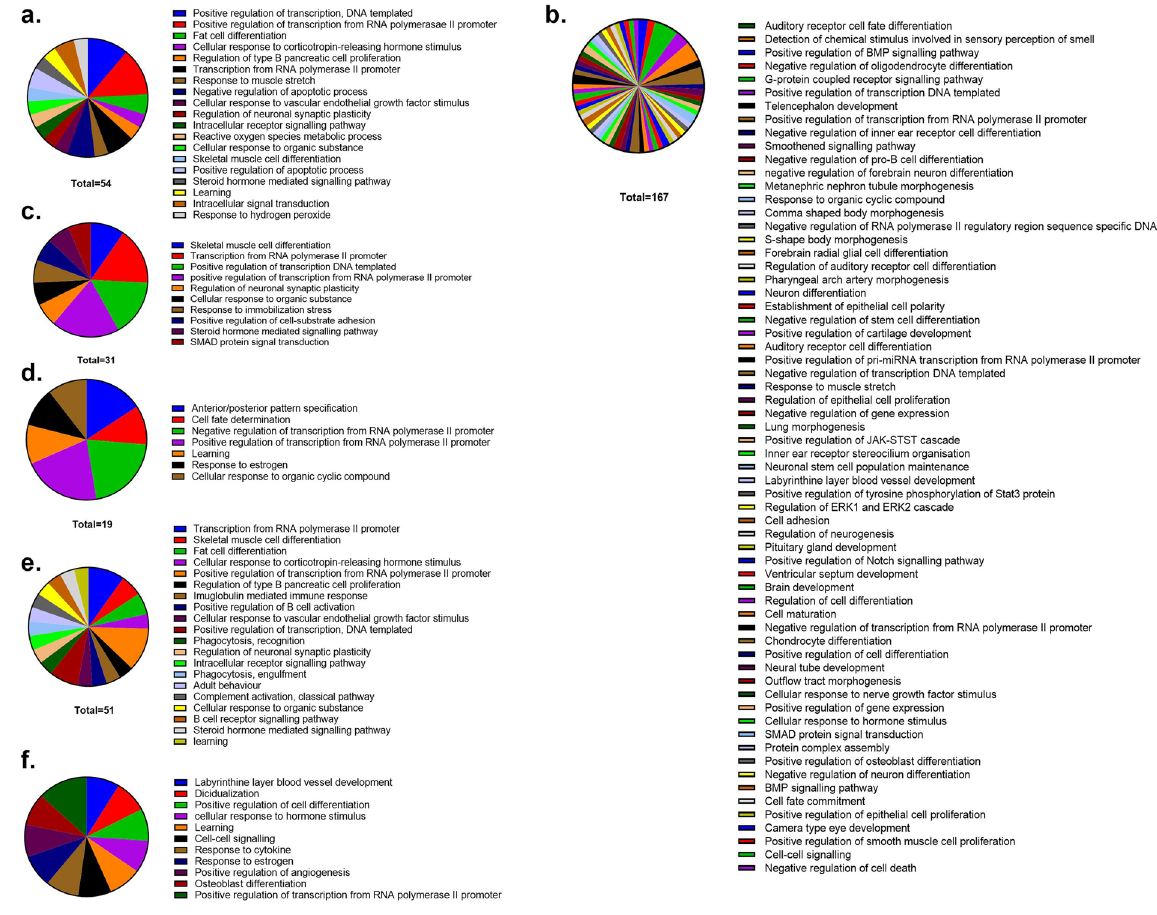
(c) Acute control vs. Acute Ketamine – 31 genes grouped into 10 clusters; (d) Chronic control vs. Chronic Ketamine – 19 genes grouped into 7 clusters; (e) Acute control vs. Acute propofol – 51 genes grouped into 20 clusters; (f) Chronic control vs. Chronic propofol – 23 genes grouped into 11